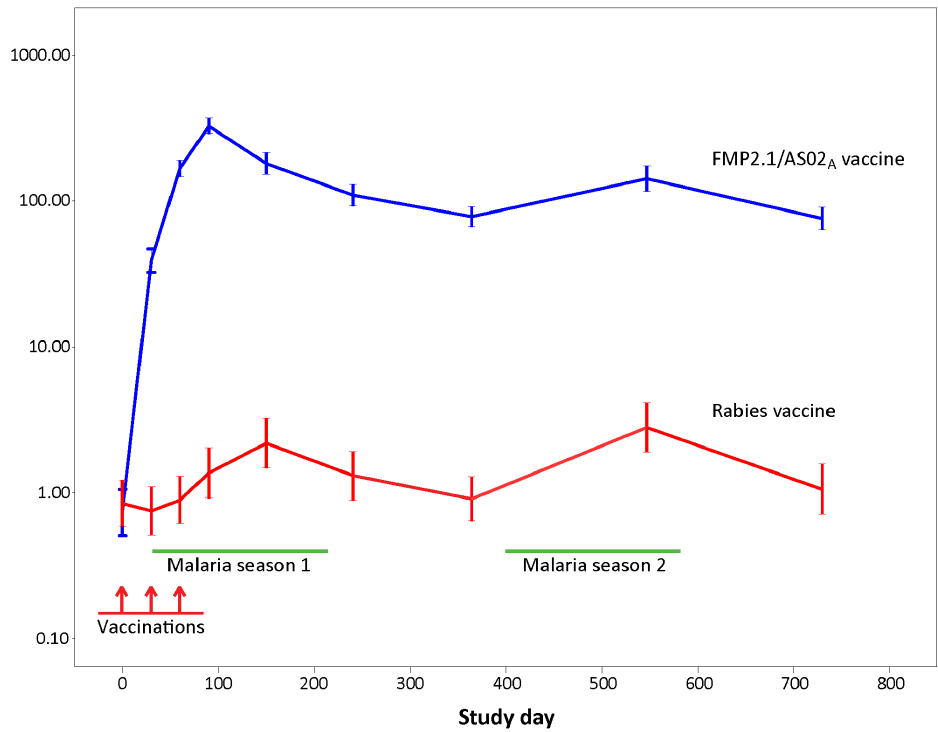
Figure 2. Levels of anti-apical membrane antigen 1 (AMA1) antibody to homologous recombinant AMA1 for FMP2.1/AS02 A vaccine and rabies vaccine recipients during the entire follow-up period (study days 0–730). Error bars indicate 95% confidence intervals.